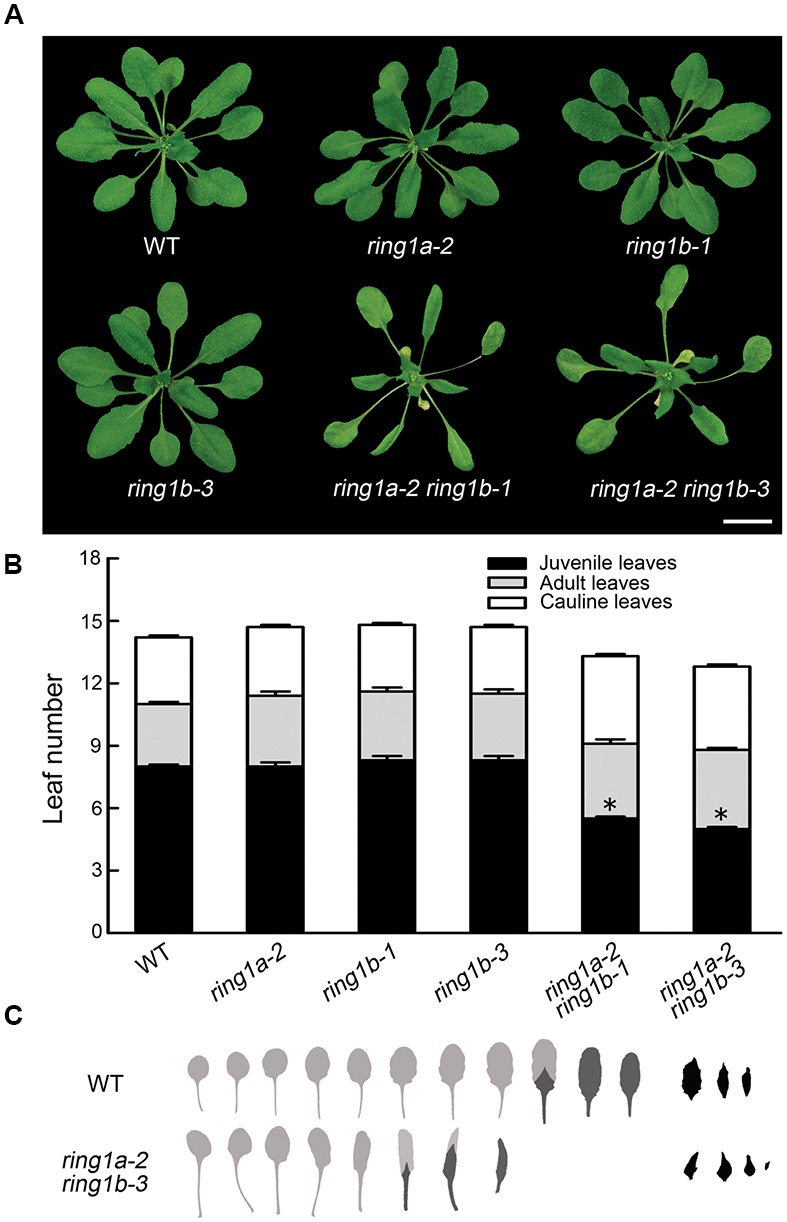
The mutation of RING1A/B causes an accelerated vegetative phase transition in Arabidopsis. (A) Phenotypes of the ring1a and ring1b plants and their double mutants. Scale bar = 1 cm. (B) Vegetative phase transition in wild-type and ring1a ring1b double mutant plants. Rosette leaves from 4-week-old wild-type plants, and single and double mutants of RING1A/B grown under LD conditions are shown. The results represent the mean ± SEM ∗ indicates p < 0.05. (C) Rosette leaf and bract morphology of wild-type and ring1a-2 ring1b-3 double mutant plants. The leaves are shown in order of their production, from left to right, and shaded to indicate juvenile leaves (light gray), adult leaves (dark gray), or bracts (black).